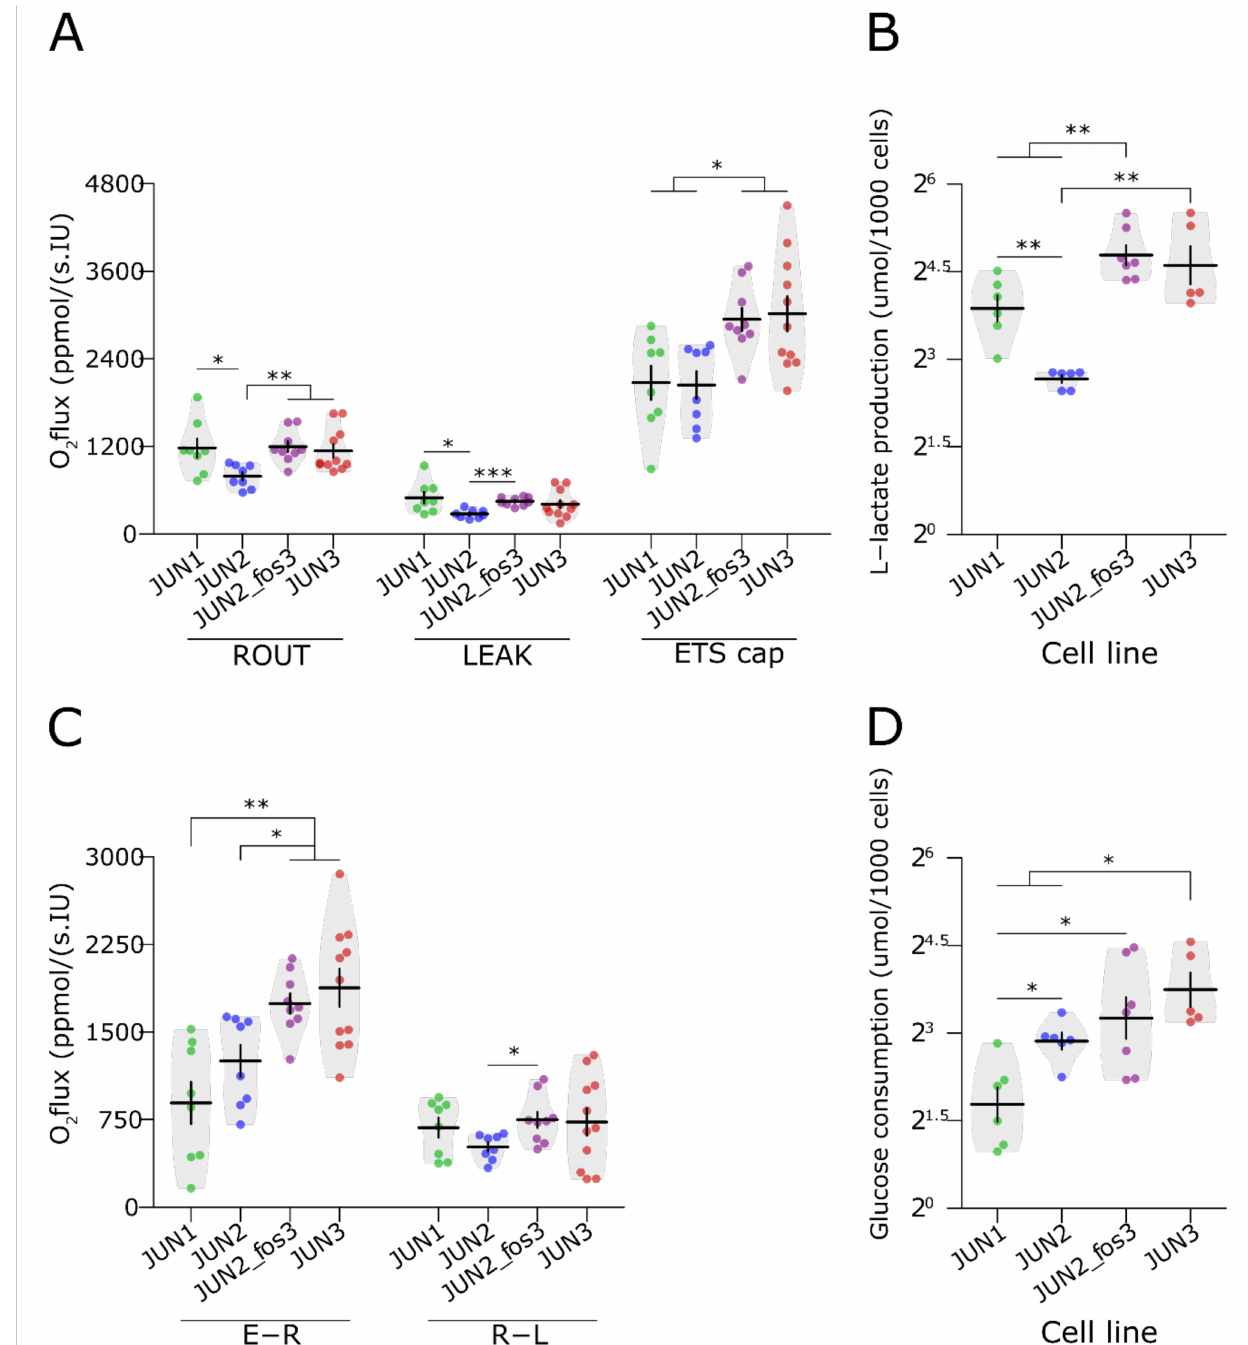
Figure 6. Metabolic analysis of JUN-sarcoma cell lines. ( A , C ) Mitochondrial oxygen consumption in JUN-sarcoma cell lines. Cell lines differed in oxygen consumptions in state R (permutational ANOVA: F 3,32 = 4, p = 0.015), L (permutational ANOVA: F 3,32 = 3.2, p < 0.032), and E (permutational ANOVA: F 3,32 = 6, p = 0.0021), and also differed in E-R capacity (permutational ANOVA: F 3,32 = 9.5, p < 0.001) but not R-L capacity (permutational ANOVA: F 3,32 = 1.3, p = 0.3). The JUN-2fos-3 cell line displayed significantly higher oxygen consumption in the states R, L, and E compared to the least transformed non-invasive, non-motile JUN-2 cells. The spare respiratory capacity (excess E-R capacity) was higher in both invasive and motile cell lines, JUN-3 and JUN-2fos-3, than in cells with limited motility and invasiveness, JUN-1 and JUN-2. ( B ) The production of L-lactate differed among JUN-sarcoma cell lines ( µ mol/1000 cells; (permutational ANOVA: F 3,20 = 25, p < 0.001). The JUN-2 cell line had a relatively high capacity of oxidative phosphorylation and the lowest production of lactate,